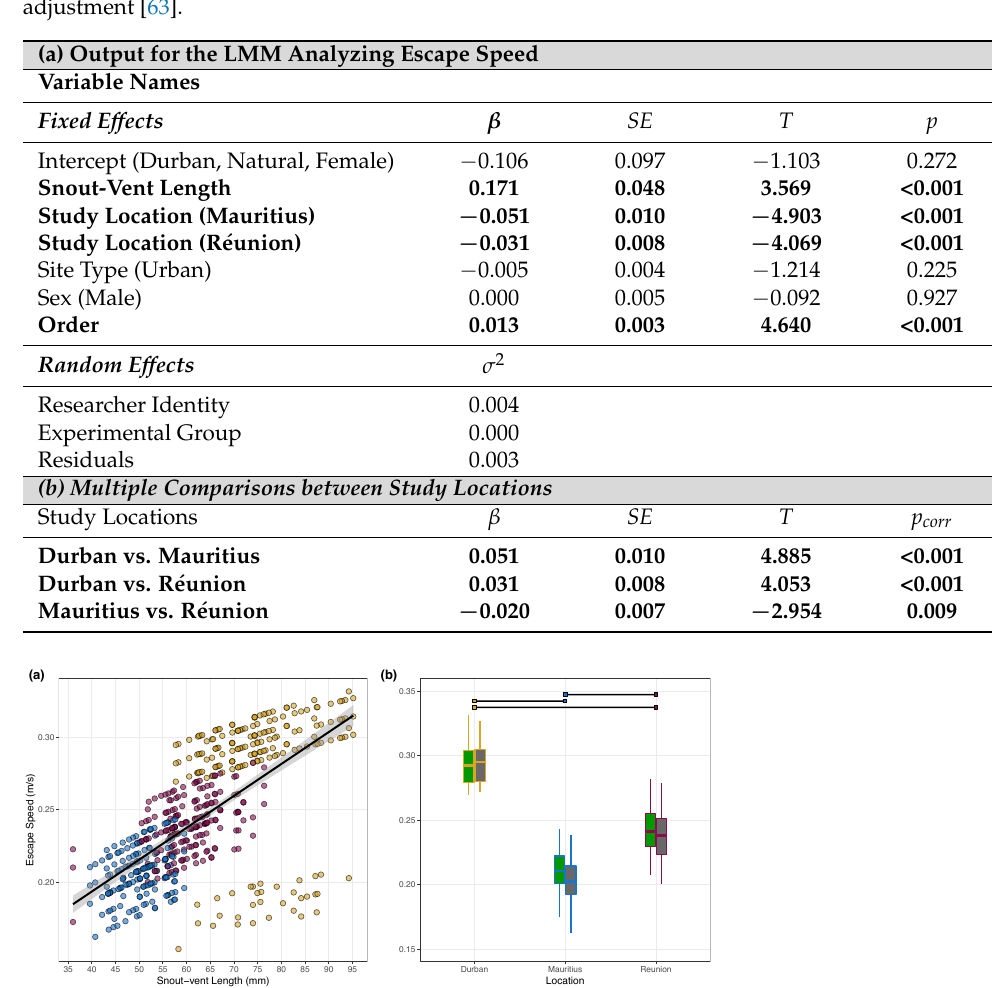
Table 6. ( a ) Outcome of the LMM examining differences in guttural toad ( Sclerophrys gutturalis ) escape speed (m/s). Since the interaction between study location and site type was not significant, it was removed and the models were re-run. Coefficient estimates ( β ) of fixed effects are presented with their corresponding standard errors ( SE ), variance estimates ( σ 2 ) are supplied for residuals and random effects, and all significant values ( p < 0.05) are bolded. Reference levels for each categorical variable are supplied in brackets following the variable name. ( b ) Post hoc multiple comparisons of escape speed between all study locations; in this case, p -values ( p corr ) were corrected using an “ mvt ” adjustment [63].